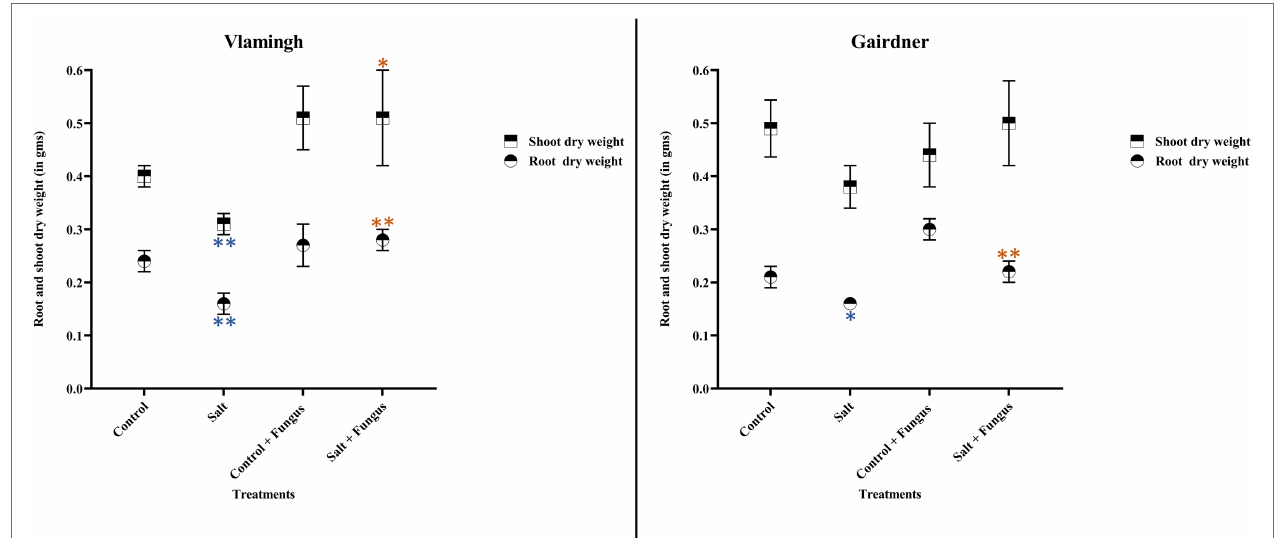
FIGURE 2 | Averages and std. errors of showing dry weight of roots and shoots of barley genotypes Vlamingh and Gairdner under four treatment conditions. X axis represent the four treatment conditions and Y axis represent weights in grams. n = 6 for both genotypes. As established by Student’s t-test, asterisks imply significance for p < 0.05 (one asterisk) and p < 0.01 (two asterisks). Three comparisons were made-uninoculated salt treatment vs. uninoculated control treatment, fungus inoculated control treatment vs. uninoculated control treatment and fungus inoculated salt treatment vs. uninoculated salt treatment. Blue colour indicates significant reduction and orange colour indicates significant increase.